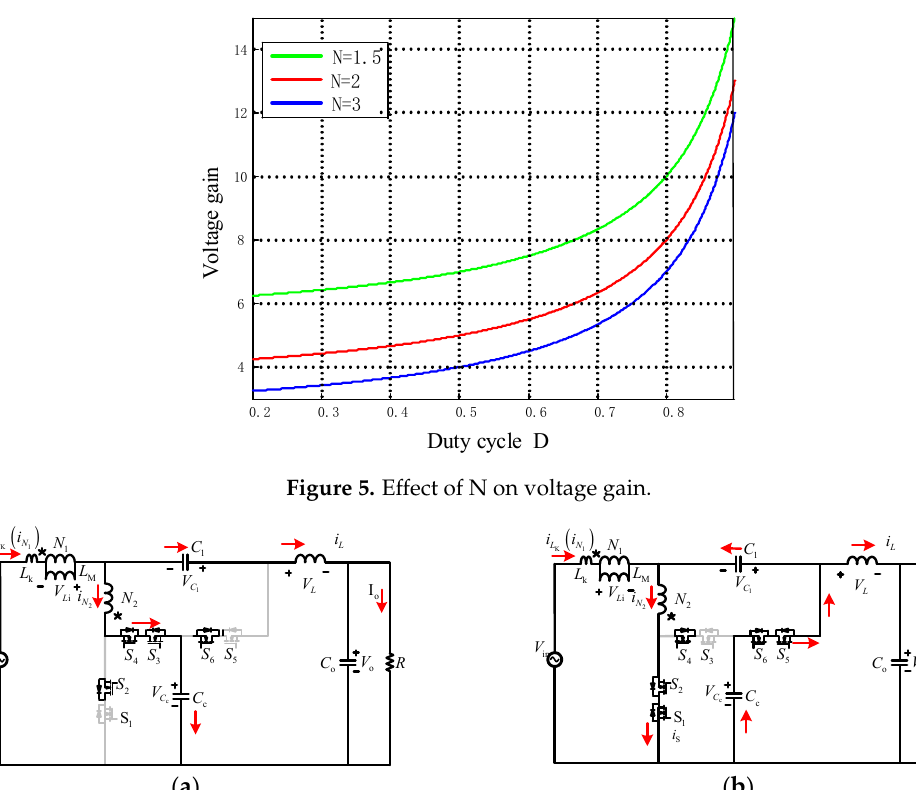
Figure 6. Operation states of the converter when V in > 0: ( a ) Non-shoot through state; ( b ) Shoot through state.